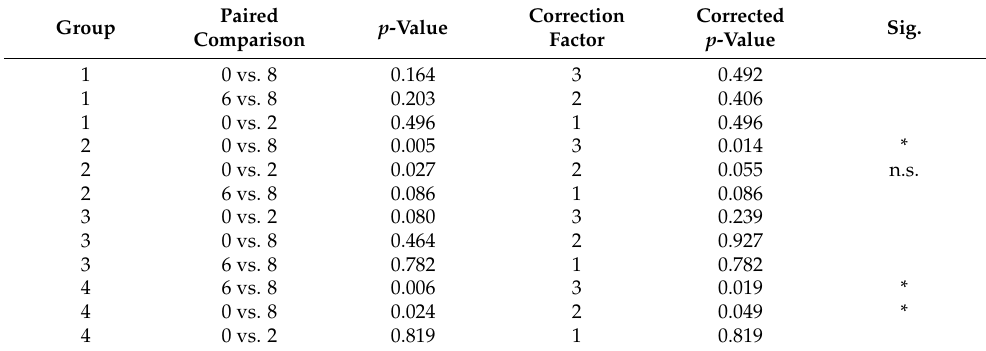
Table A5. Bonferroni–Holm-corrected p -values for the ratio of cfDNA/DNase activity.